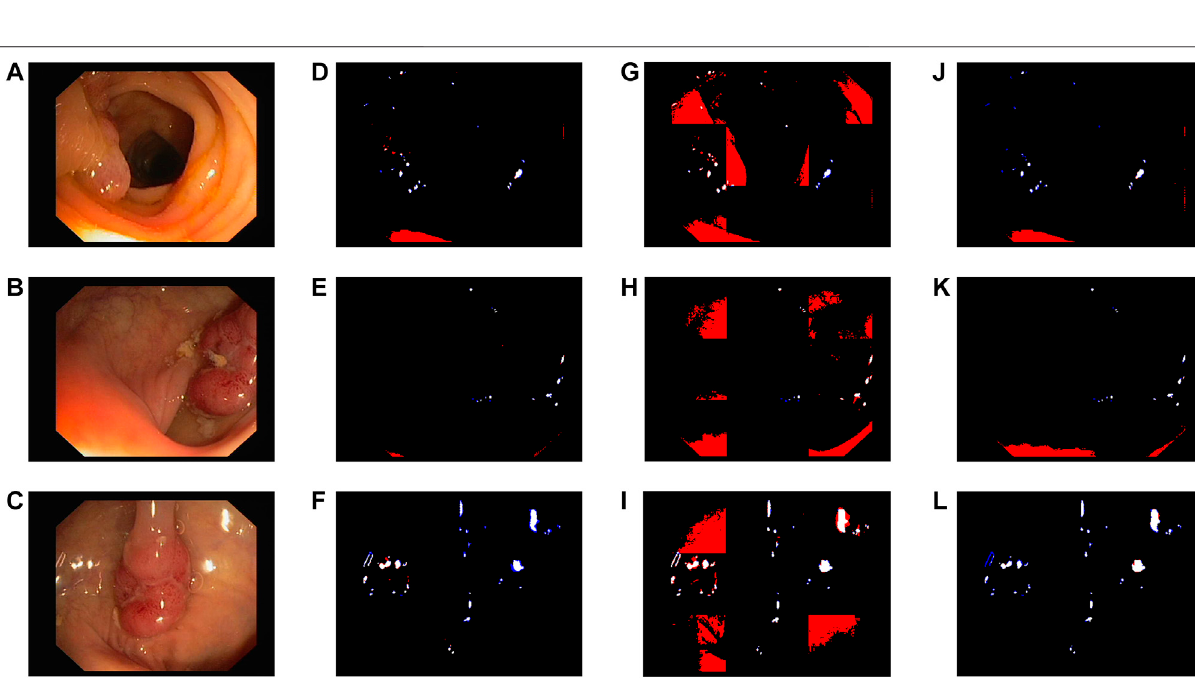
Frontiers in Physics |